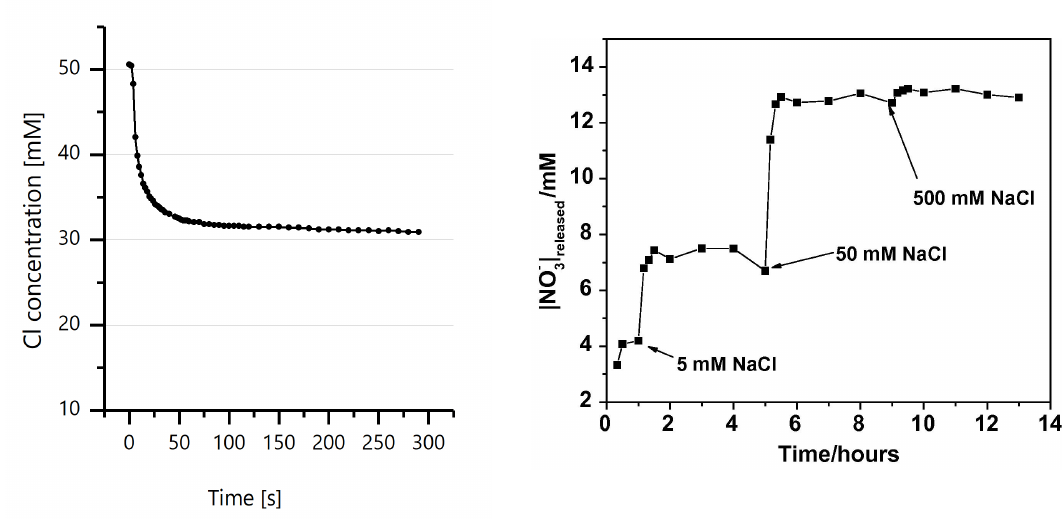
Figure 3. ( Left ) Decrease in chloride ion concentration due to addition of Zn-Al-NO 2 to the solution containing 50mM of initial chloride concentration. ( Right ) Release of NO 3 − ion from Zn-Al-NO 3 after exposure to Cl − ion (reprinted from [94] with permission from